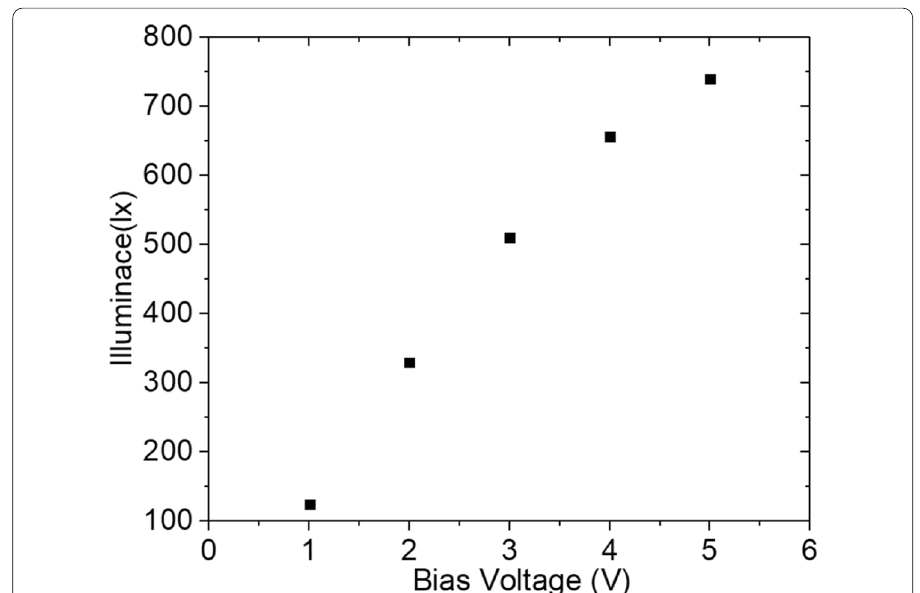
Fig. 4 Illuminance versus bias voltage of LED device under “constant voltage amplitude and constant heatsink temperature”